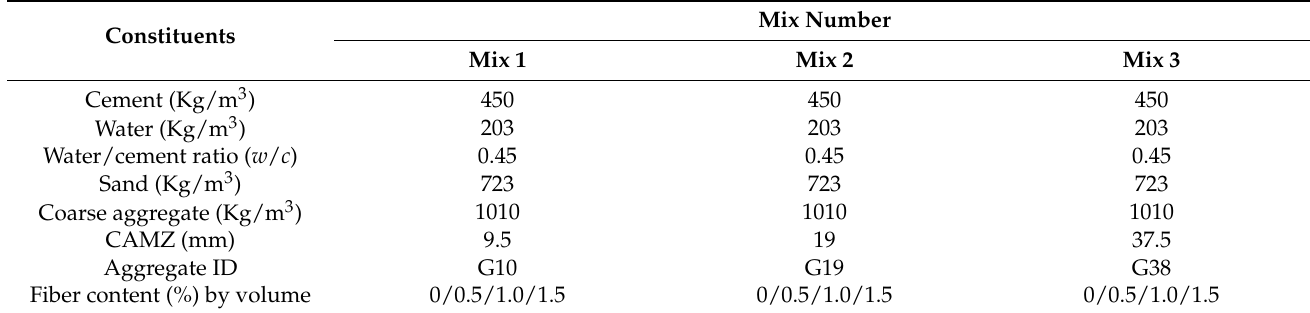
Table 6. Mix constituents.